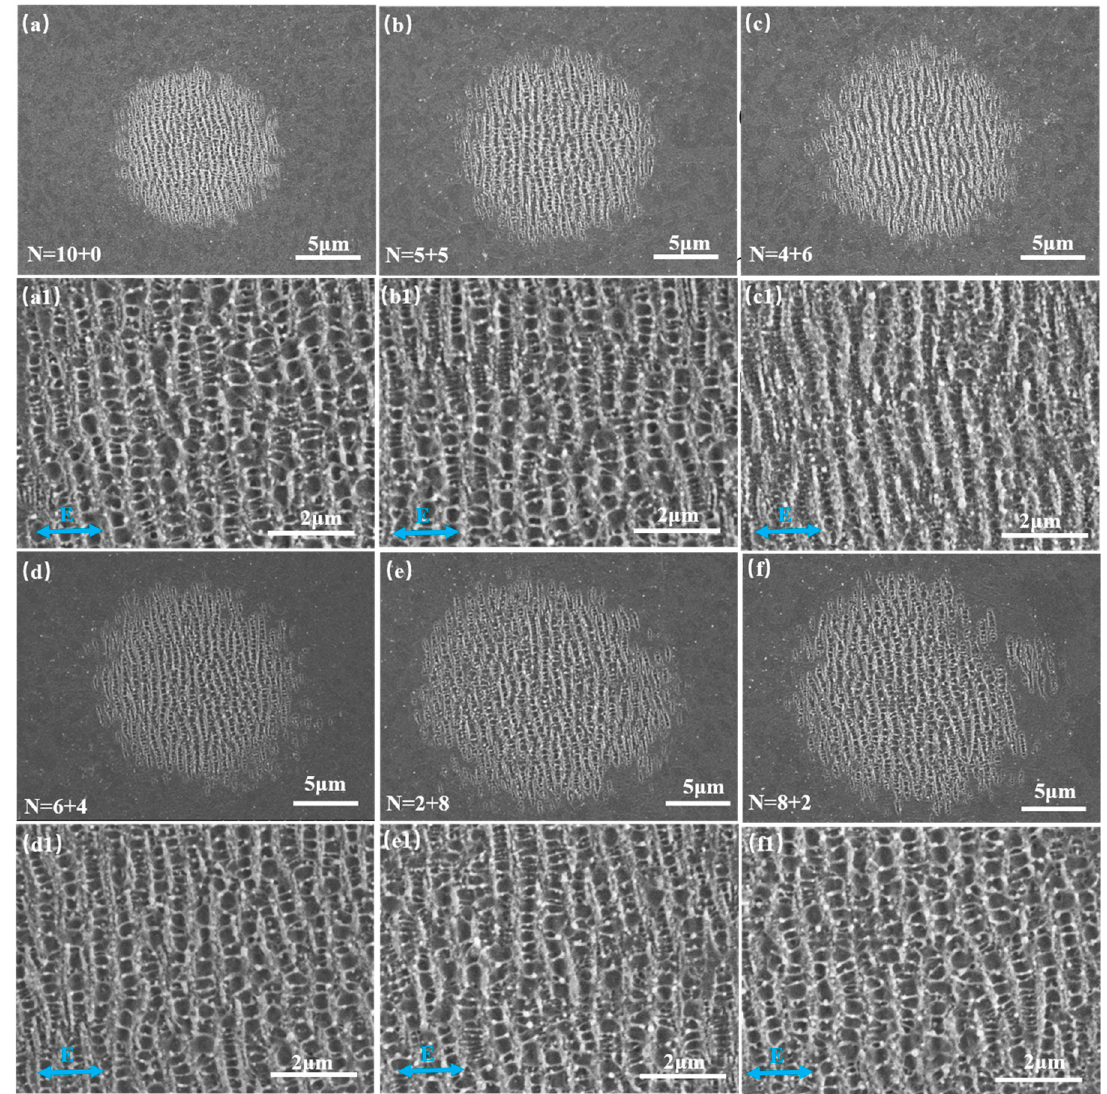
Figure 4. SEM images of ablation morphology and subwavelength ripples on titanium at different femtosecond laser pulse irradiation modes: ( a-a1 ) N = 10 + 0, ( b-b1 ) N = 5 + 5, ( c-c1 ) N = 4 + 6, ( d-d1 ) N = 6 + 4, ( e-e1 ) N = 2 + 8, and ( f-f1 ) N = 8 + 2. ( a1–f1 ) show the magnification of the ripple structures in the central region in ( a − f ), respectively. The total pulse number is 10 in all cases. The laser pulse energy is fixed at 0.20 J/cm 2 in all cases.